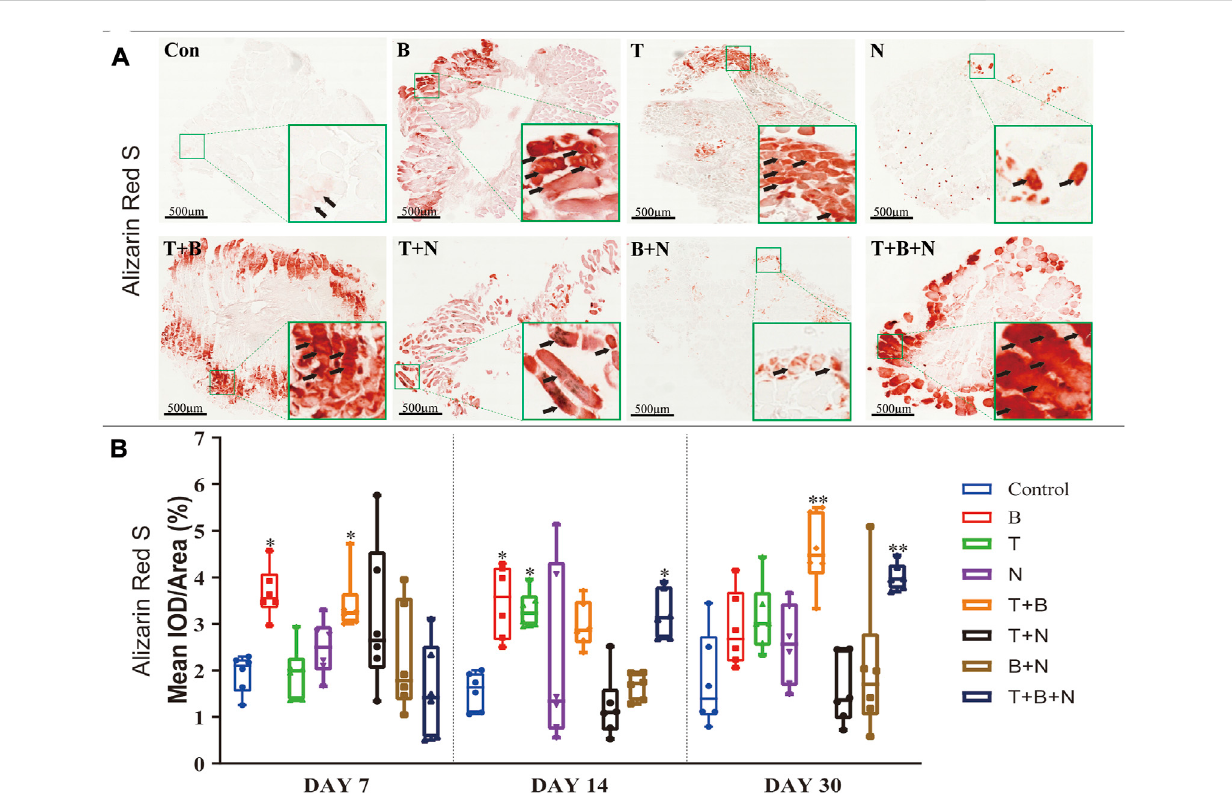
FIGURE 5 The staining results of Alizarin Red S in each group. (A) Staining results on day 30; the positive staining color was red (marked by black arrows). (B) Histomorphometrical assessment; the result was shown as Mean IOD/Area. Control group vs. stimulated groups at 7, 14, and 30 days; the asterisks indicatethatthestimulatedgroupisstatisticallysigni fi cantcomparedtothecontrolgroup.(Magni fi cation:×40;n=6;* p < 0.05;** p < 0.01;*** p <